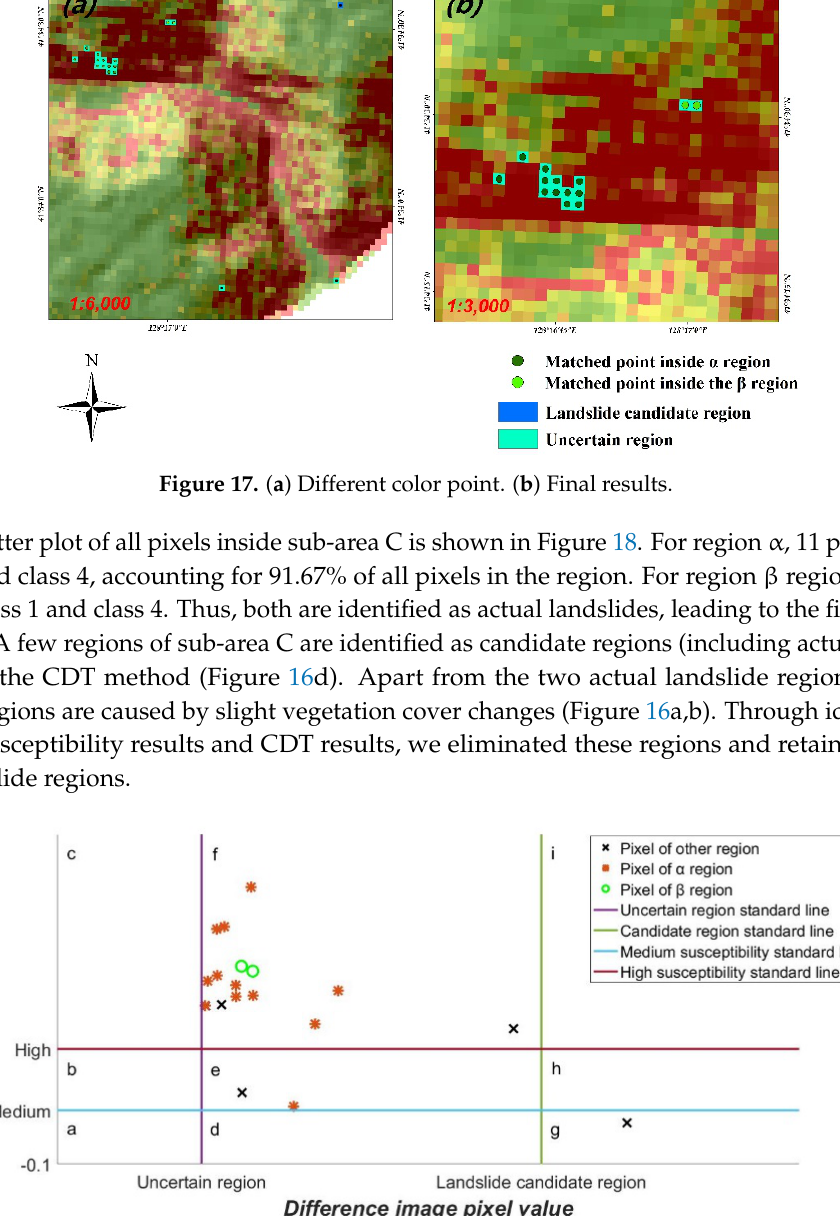
Figure 16. Landslide identification results in sub-area B. ( a ) Pre-event images; ( b ) post-event images; ( c ) difference image; ( d ) thresholding results; ( e ) susceptibility results; ( f ) overlapping; ( g ) final results. Different colors represent pixels inside the two landslide reference boundaries and black indicates pixels outside the boundary (Figure 17a). α and β regions are the code name of two landslide regions occurred in this sub-area.